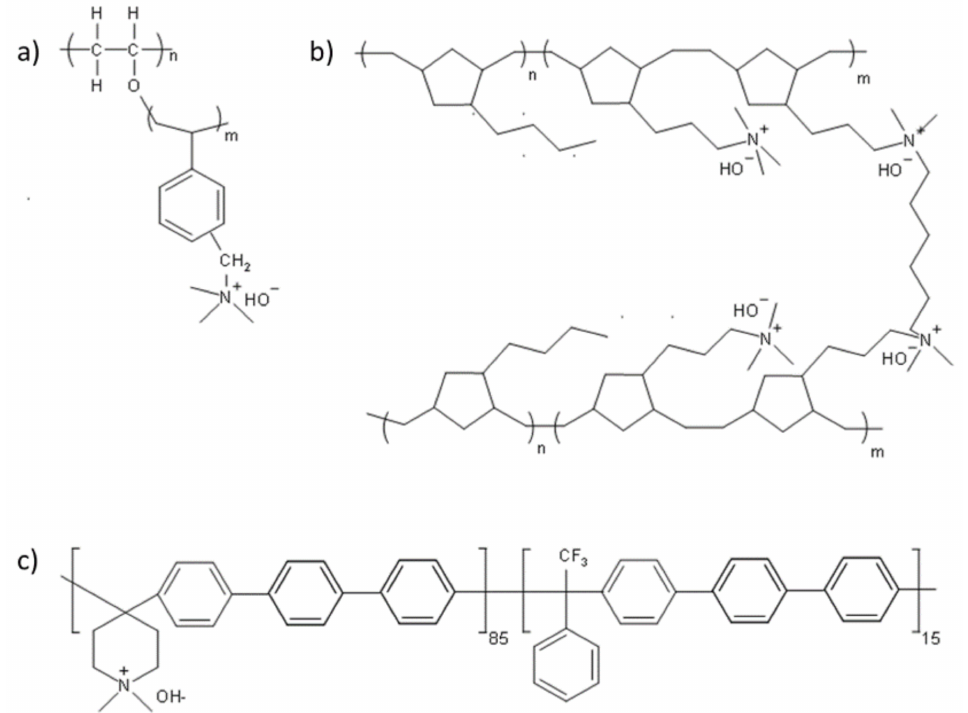
Figure 6. The structure of anion exchange membranes (AEMs) used in this study ( a ) high-density polyethylene polymer with a benzyltrimethylammonium cation (HDPE-BTMA) and low-density polyethylene polymer with a benzyltrimethylammonium cation (LDPE-BTMA), ( b ) poly (norbornene) copolymer of GT64-15, GT72-5 and GT78-15 and ( c ) poly(aryl piperidinium)-based polymer with a terphenyl chain (PAP-TP-85). (Reprinted with permission from ref. [93] Copyright 2021